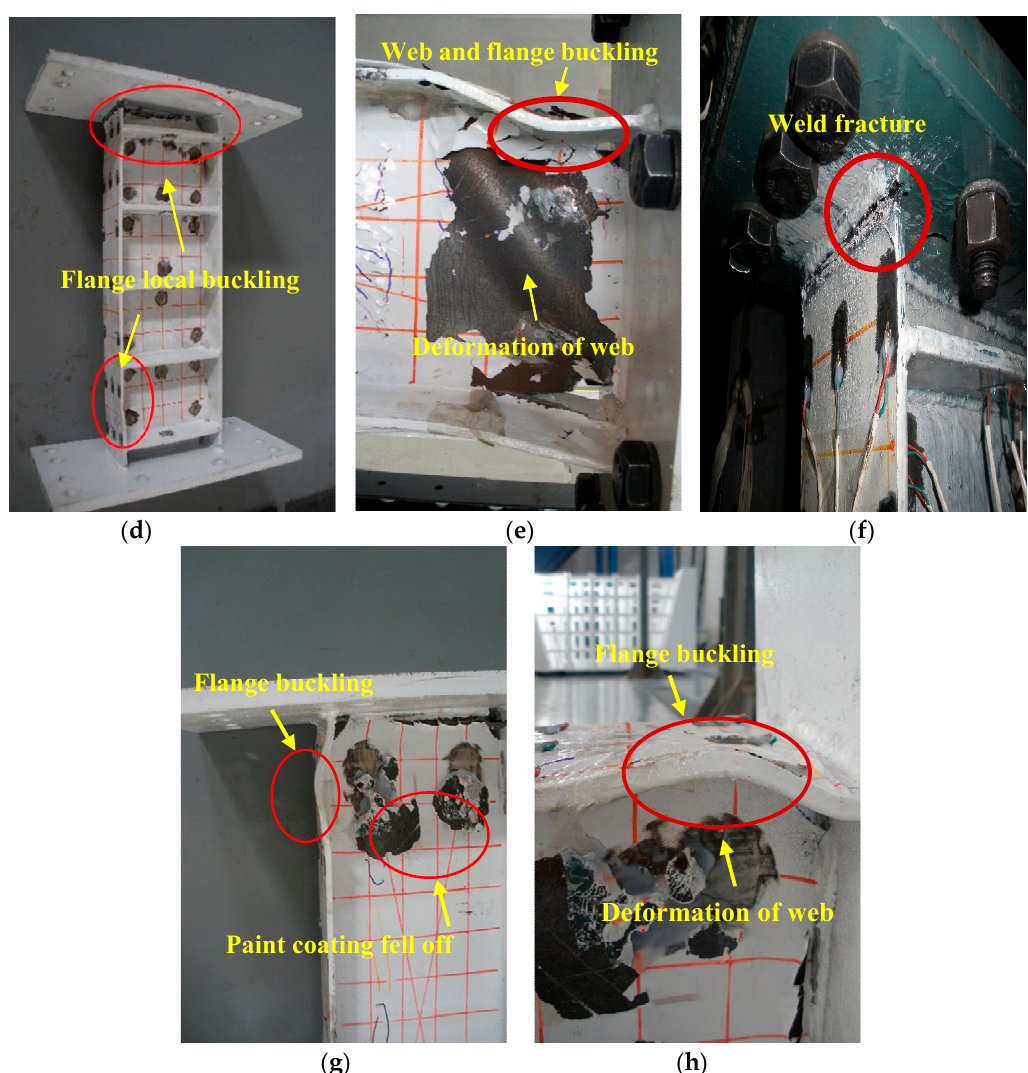
Figure 7. Failure modes of specimens at final stage. ( a ) L1; ( b ) L2; ( c ) L3; ( d ) L4; ( e ) L5; ( f ) L6; ( g ) L7; ( h ) L8.